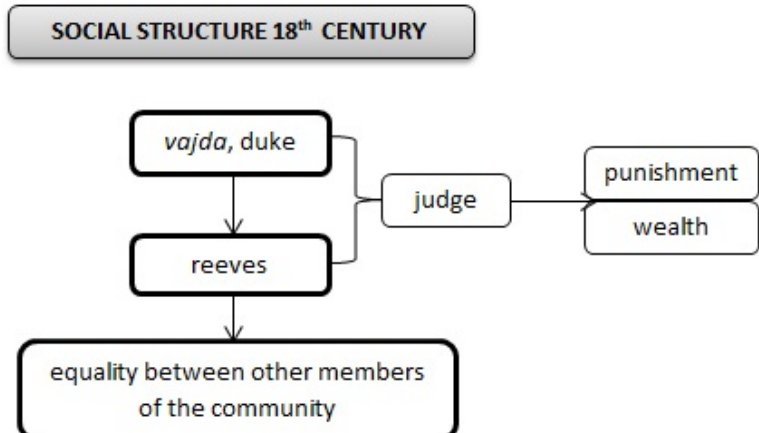
Figure 5. Roma social structure in the 18th century.